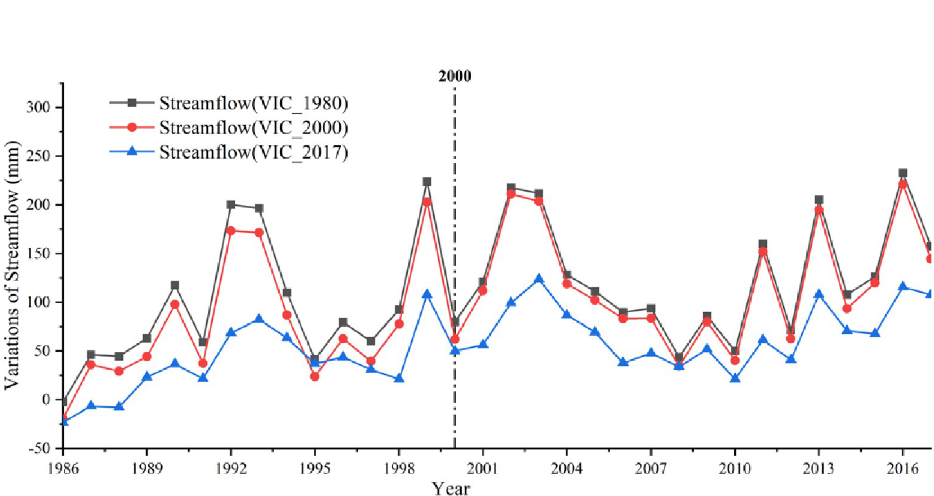
Fig 10. Variations in runoff depth driven by VIC_1980, VIC_2000, and VIC_2017 for the entire